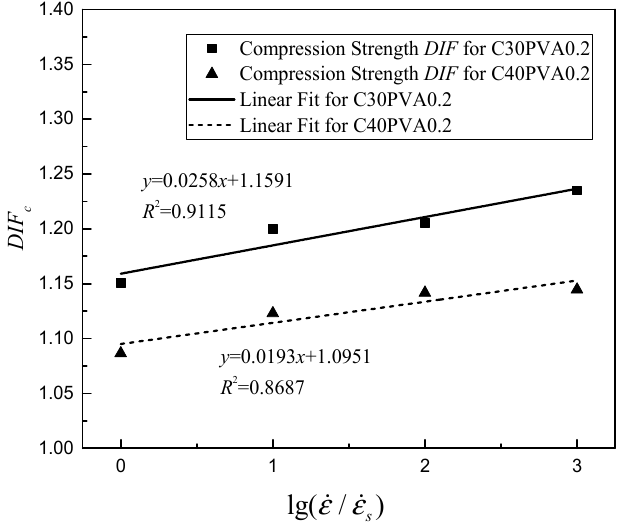
Figure 5. Fitting curves of compressive strength DIF c for C30PVA0.2 and C40PVA0.2.